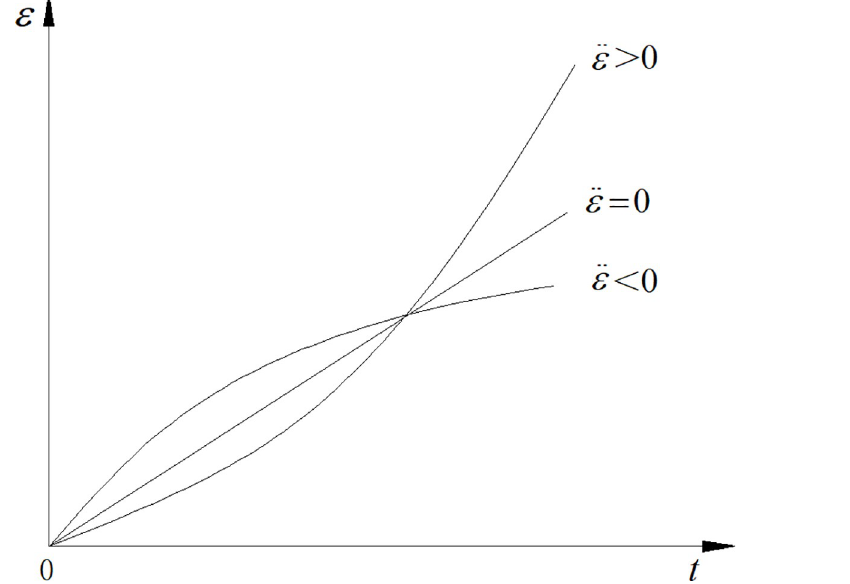
Fig 7. Creep characteristics of